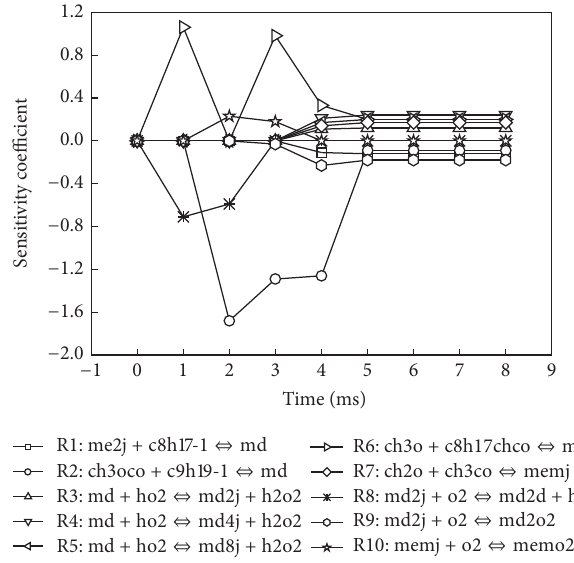
Figure 4: Sensitivity analysis of